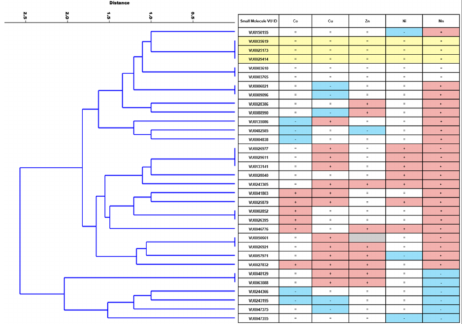
Figure 5. Hierarchical clustering analysis of small molecule activity for the 33 molecules screened reveals unique patterns of activity across the library. A direction (increase, decrease, no change) was assigned to each small molecule for each divalent metal based on the statistically significant results of the screening process. If no significant effect was detected, no change (marked with a “=”) was imputed. A dendrogram was then generated using a multivariate classical clustering method, a paired group algorithm, and a Euclidean similarity index. Of the 33 small molecules screened, the majority of molecules did not cluster together, demonstrating 24 distinct metal activity profiles. The assigned functional activity is listed in the table at the right of the dendrogramF and was based on the deductive logic described in the flow chart of Figure 2. Due to conflicting results in the screens, the directionality of one small molecule (VU0050661) could not be determined for Zn (marked in grey). Metal “increasers” are denoted with a “+” in a red square. Metal “decreasers” are denoted with a “-” in blue